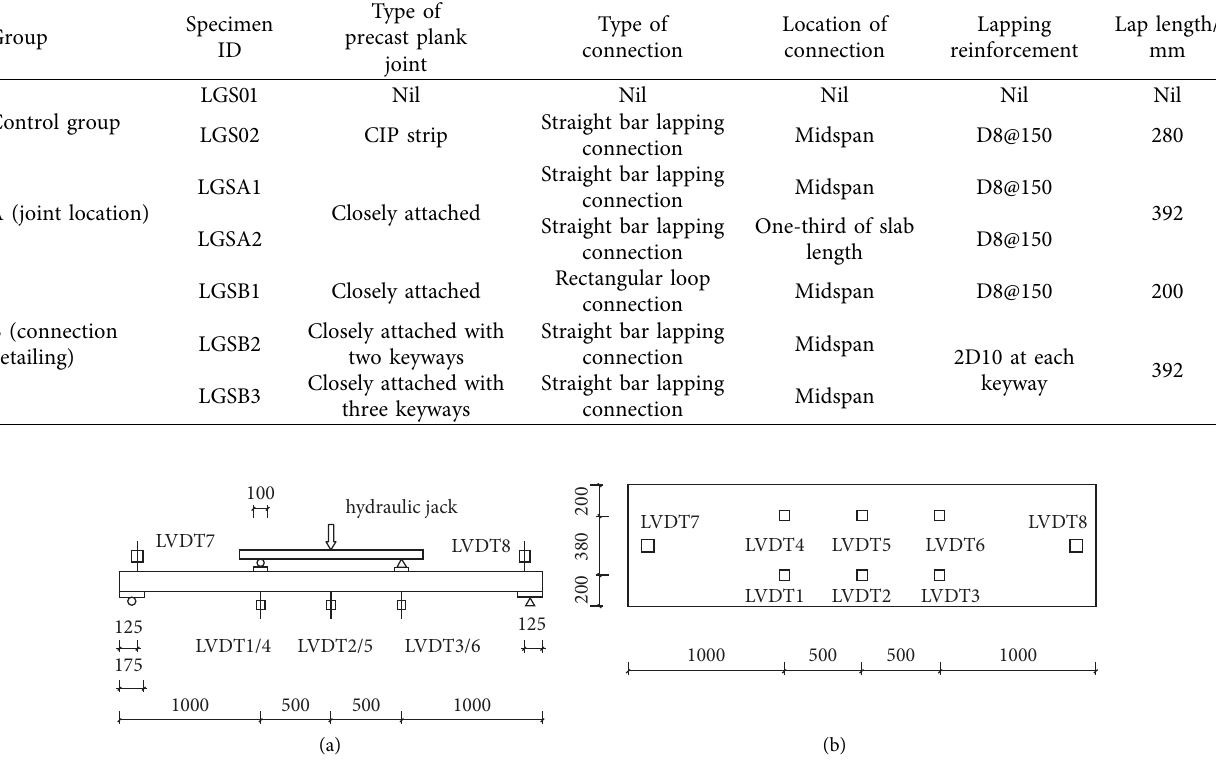
Table 1: Details of specimens.